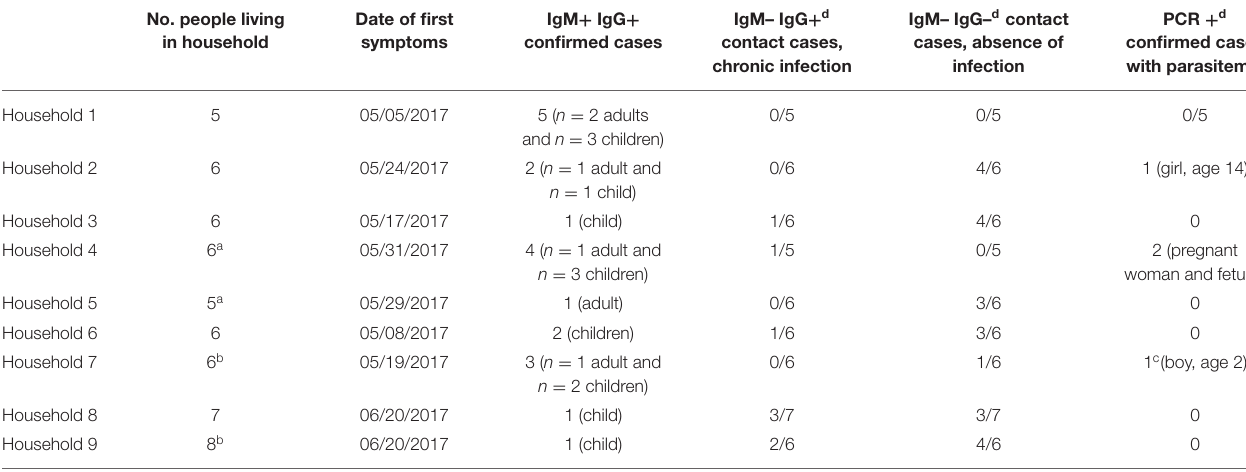
TABLE 1 | Epidemiological investigation of the 9 infected households, Camopi, French Guiana. No. people living in